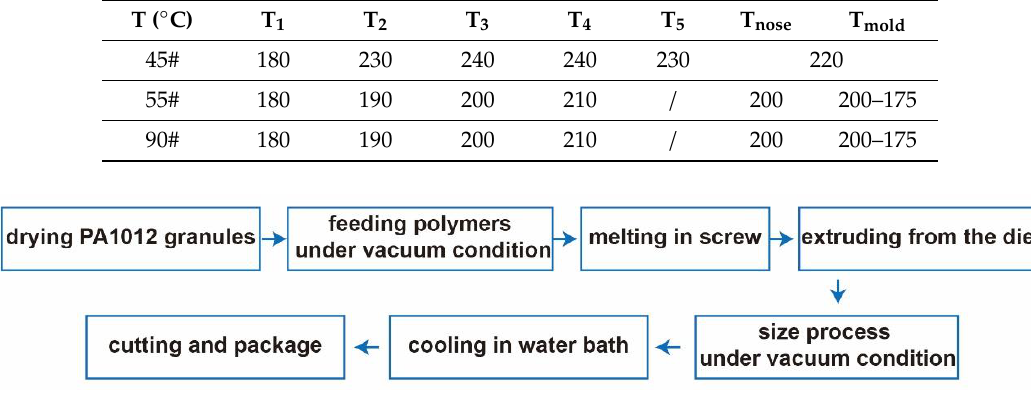
Figure 1. The procedures of fabricating fuel pipes for automobiles. Table 2. Specific temperature of every section for the single-screw extruding process.